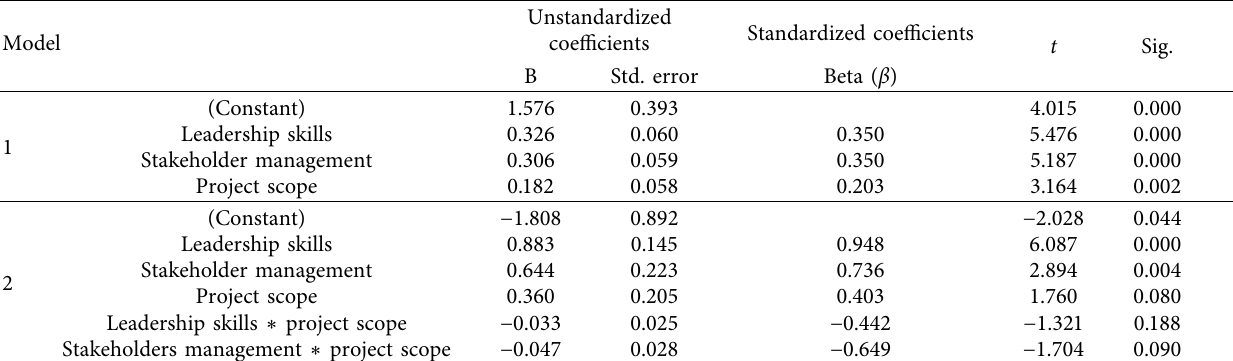
Table 9: Coefficients for leadership skills, stakeholder management, project scope, and execution of fibre optic infrastructure.